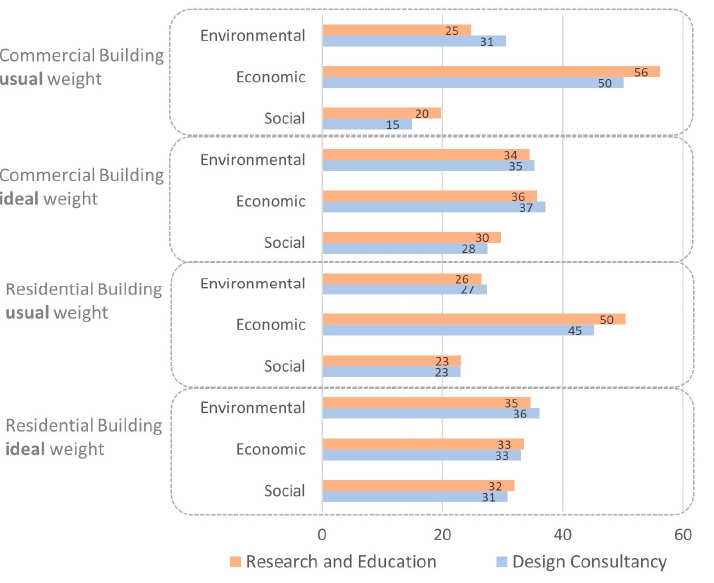
Figure 3. Weight of sustainability dimensions with respect to respondents’ area of belonging.